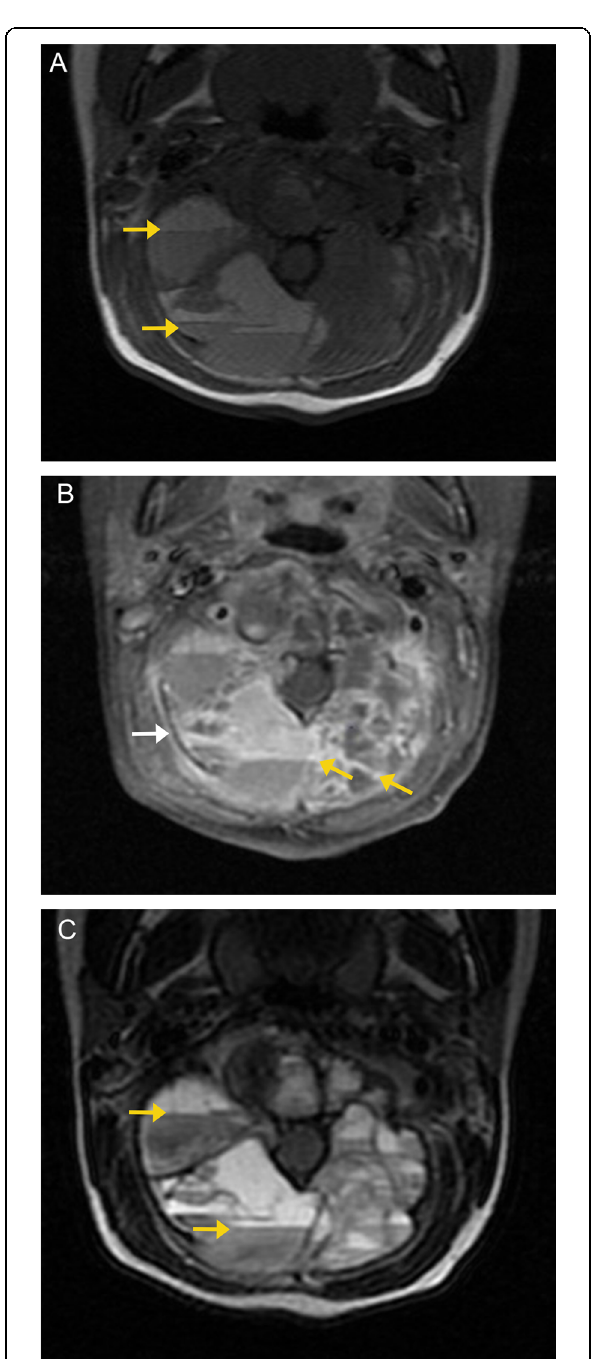
Fig. 10 Aneurysmal bone cyst. MRI imaging in the same patient as Fig 9. Pre-contrast axial T1-weighted image ( a ) confirms fluid-fluid levels within the lesion (orange arrows), indicating hemorrhage with sedimentation of varying stages of blood products. Post- contrast axial T1-weighted image ( b ) demonstrates enhancement of the septa within the lesion (orange arrows). Note a partially hypointense rim, representing cortex (white arrow). Axial T2- weighted image ( c ) re-demonstrates a destructive lesion with fluid- fluid levels (orange arrows); varying signal intensity corresponds to differing stages of blood product